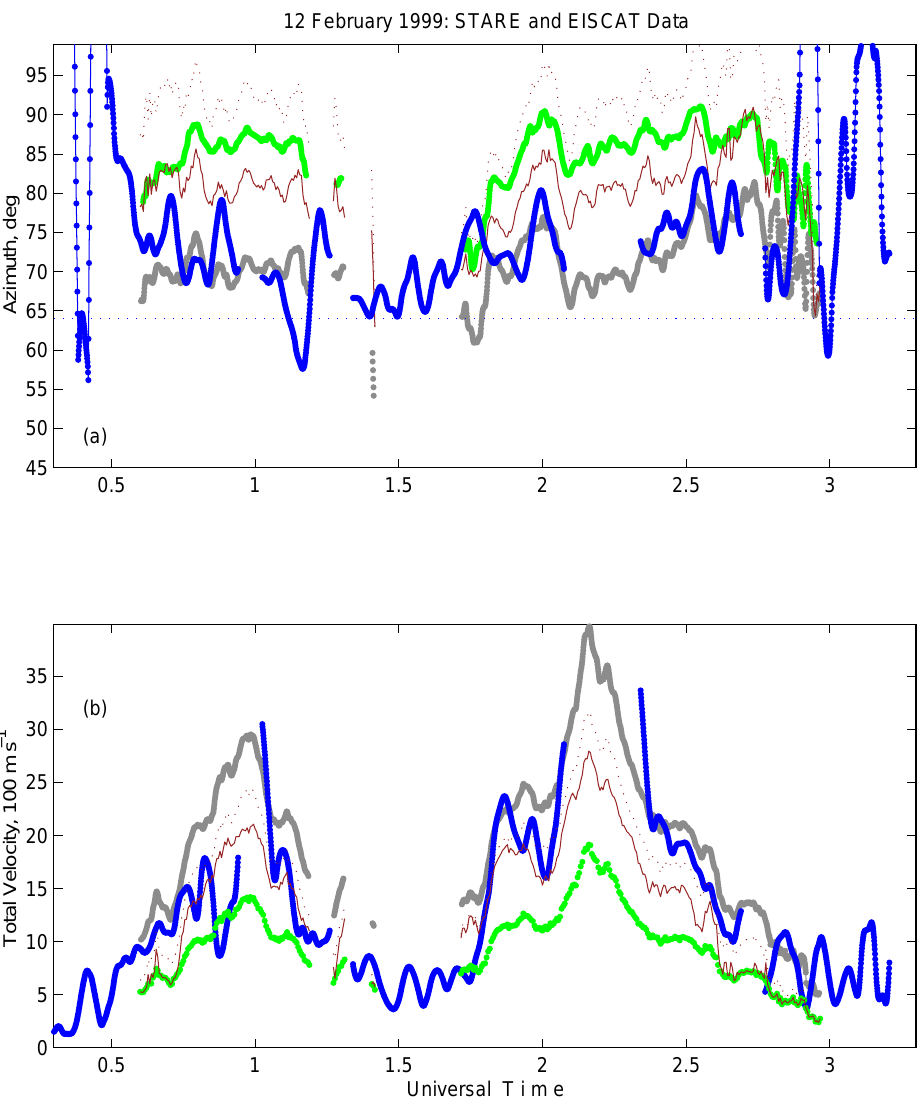
Figure 7: Uspensky et al. Fig. 7. (a) The standard merged STARE irregularity drift velocity and EISCAT V E × B velocity azimuth, blue and green lines, respectively, together with the IAA-predicted electron flow azimuth, dark red dashed line, and the OOFA-predicted electron flow azimuth, grey line; dotted line is the IAA(Norway)/OOFA(Finland) predicted electron flow azimuth, (b) The standard merged STARE and EISCAT flow velocity magnitude, green and blue lines, together with overlapped the IAA-predicted electron velocity 7 magnitude, dark red dashed line, the OOFA- predicted electron velocity magnitude, grey line, and the IAA/OOFA-predicted electron velocity magnitude, dotted line.